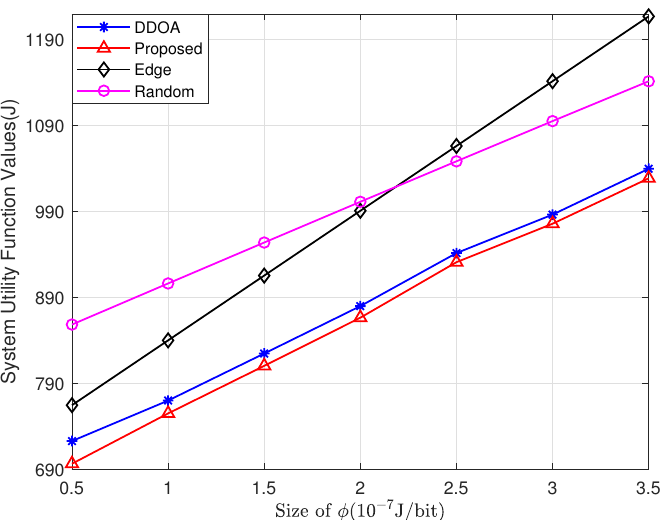
Figure 5. The system utility function values under different parameters φ for different offloading